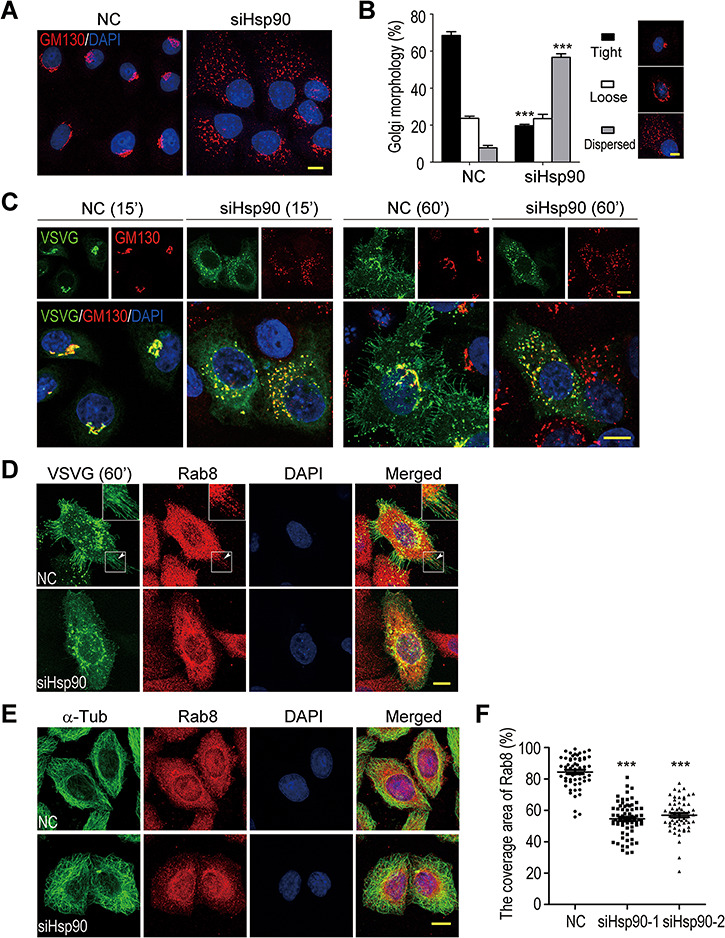
Golgi fragmentation and Rab8 mislocalization in Hsp90-depleted cells. (A) The Golgi of Hsp90-depleted HeLa cells. Cells were stained with anti-GM130 antibody to show the Golgi apparatus. (B) Quantification of the Golgi with various morphologies in control and Hsp90-depleted cells. Golgi morphologies were categorized into tight, loose, and dispersed types. The results were the average of three independent experiments, and at least 500 cells were analyzed per group for each experiment. Error bars represent SEM. Student’s t-test, ***P < 0.001. (C) Retention of VSVGtsO45-GFP in fragmented Golgi patches of Hsp90-depleted cells at the permissive 32°C after 15 and 60 min. GM130 was stained to show the Golgi. (D) Rab8 in cytoplasm of control and Hsp90-depleted cells. Cells were shifted to the permissive temperature for 60-min incubation (60′). Rab8 and VSVGtsO45-GFP were detected by immunofluorescence or GFP fluorescence. The arrow heads indicate Rab8 in the VSVG-localizing plasma membrane protrusions. The boxed area is enlarged to show details. (E) Retention of Rab8 in perinuclear region of Hsp90-depleted cells. α-tubulin (α-Tub) was stained to show the cell outline. (F) Quantification of cytoplasmic area with Rab8 in control or Hsp90-depleted cells. The results were the ratio of the Rab8-covered area relative to the cell outline area. Data are mean ± SEM of the results obtained from at least 59 cells for each group. Student’s t-test, ***P < 0.001. Scale bar, 10 μm.